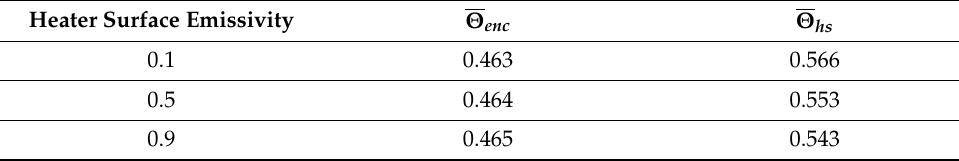
Table 4. Variations of various parameters for l/L = 0.2, τ =